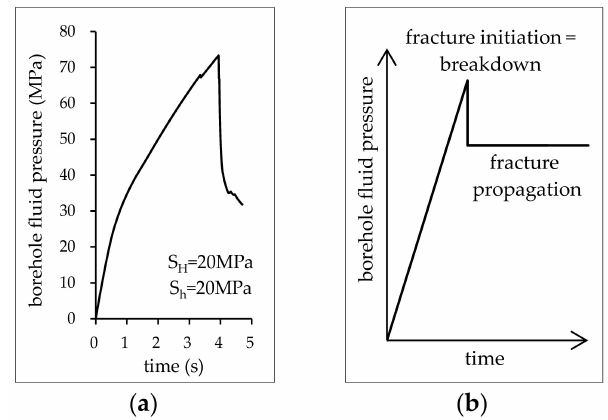
Figure 5. Borehole fluid pressure curves: ( a ) simulated curve and ( b ) idealized curve